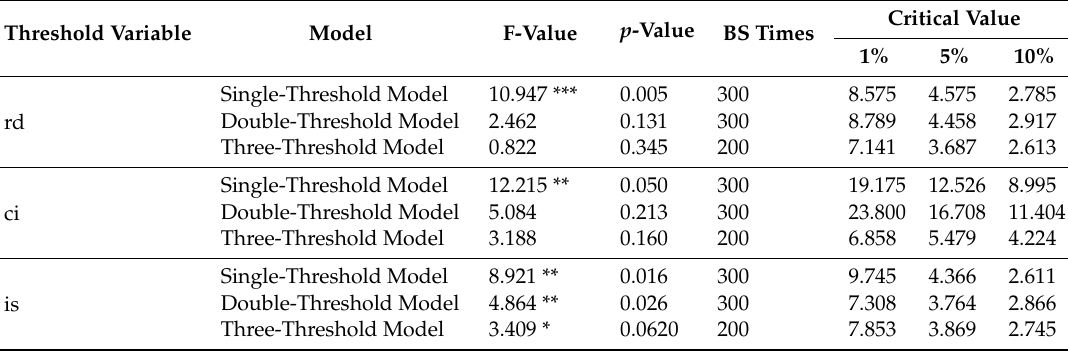
Table 6. Threshold e ff ect test results foreign investment and carbon